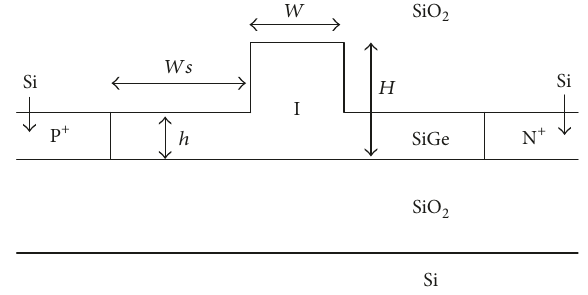
Figure 1: Si/SiGe/Si-OI